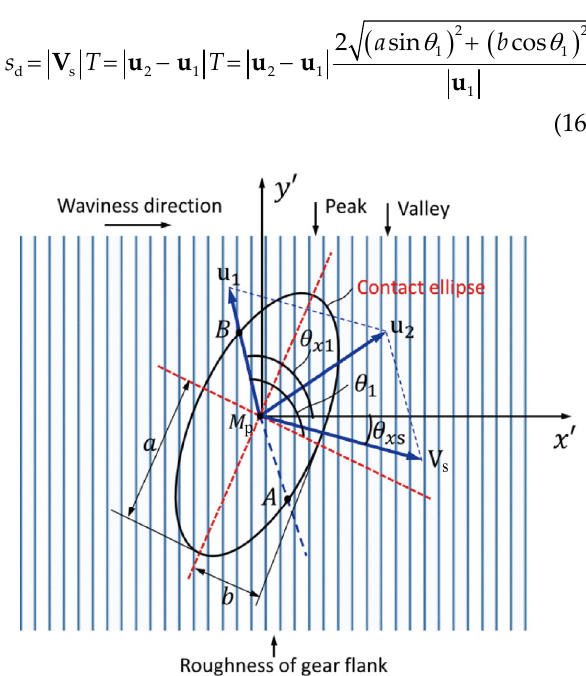
Fig. 4 Contact geometry in tangential plane 